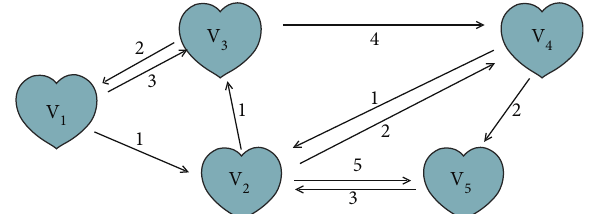
Figure 1: Simulation of the scenic spot network